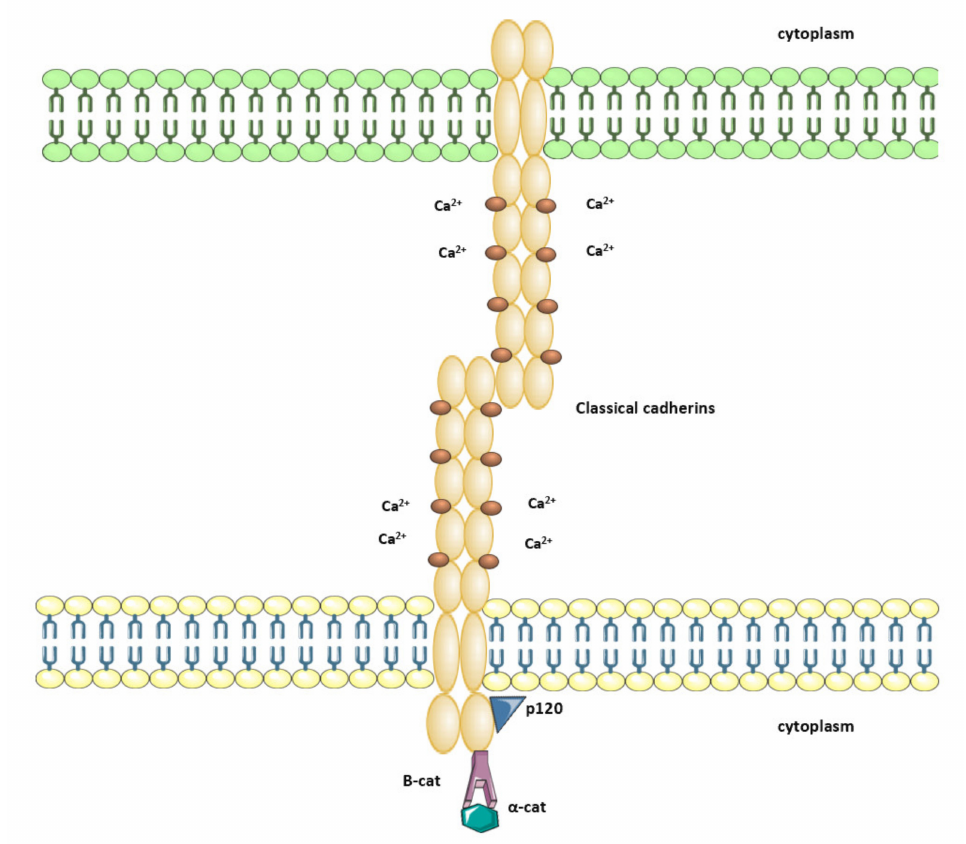
Figure 1. Scheme of the cadherin-catenin complex based on Gama et al. 2012 [29]. Cadherins have extracellular domain, transmembrane domain and a cytoplasmic tail. These transmembrane domains are composed of five cadherin repeats and are responsible for calcium dependent cell-cell adhesion. The cytoplasmic tail is composed of a juxtamembrane domain (proximal to the plasma membrane), which binds to p120-catenin, and a catenin-binding domain, which binds to β -catenin. β -catenin binds to α -catenin, which links cadherins to the actin